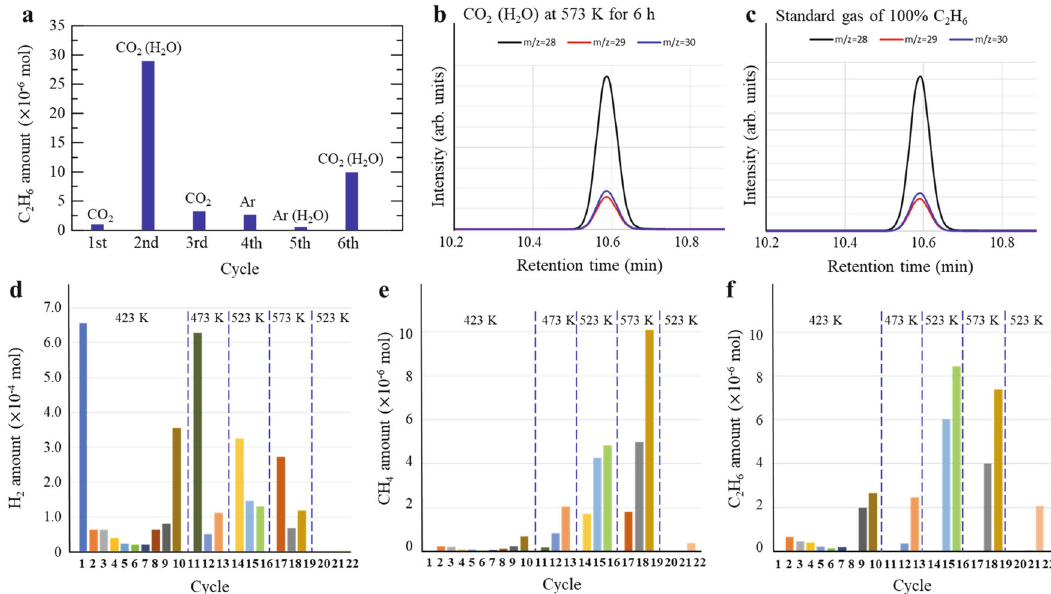
Fig. 4 Reaction product of CO 2 with hydrogen boride (HB) upon cycling. a Amount of C 2 H 6 produced upon cycling. The labels identify the reactants supplied to the system in each cycle. Before the measurements, the HB sample was heated at 523 K for 6 h in Ar to create hydrogen vacancies in the HB sheets (100 mg). For each cycle, the gas was changed to CO 2 or Ar at 300 K, and the HB sheets were heated at 373 K in a fl ow of CO 2 or Ar. In the second, fi fth, and sixth cycles, when the temperature reached 373 K, 0.1 cm 3 of H 2 O was added to the system using a syringe. Thereafter, the reactor was closed, the gas fl ow was stopped, and the temperature was increased to 523 K. The sample was held at 523 K for 6 h. b , c Mass patterns of detected gas and standard gas. The reaction products were analyzed using gas chromatography-mass spectrometry (GC-MS). C 2 H 6 was veri fi ed by comparing its GC-MS signal ( b ) with that of standard gas of 100% C 2 H 6 ( c ). d – f Amounts of ( d ) H 2 , ( e ) CH 4 , and ( f ) C 2 H 6 produced upon cycling by continuously using the same HB sample (100 mg). The atmospheres used for each cycle (6 h) were as follows. At 423 K: cycles 1 – 7, Ar gas; cycle 8, CO 2 gas; cycles 9 and 10, CO 2 + 0.1 cm 3 H fl ow; cycles 12, 15, 18, and 21: Ar gas; cycles 13, 16, 19, and 22, CO + 0.1 cm 3 2 O. At 473, 523, 573, and again 523 K: cycles 11, 14, 17, and 20, Ar 2 H 2 O. The experiments were performed from left to right along the horizontal